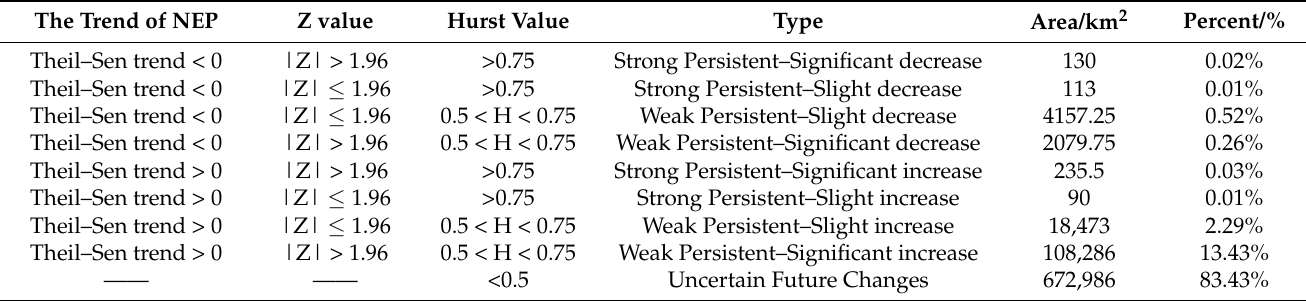
Figure 12. Distribution of future persistent changes in NEP. Table 3. Statistical results of NEP trends and the Hurst index.